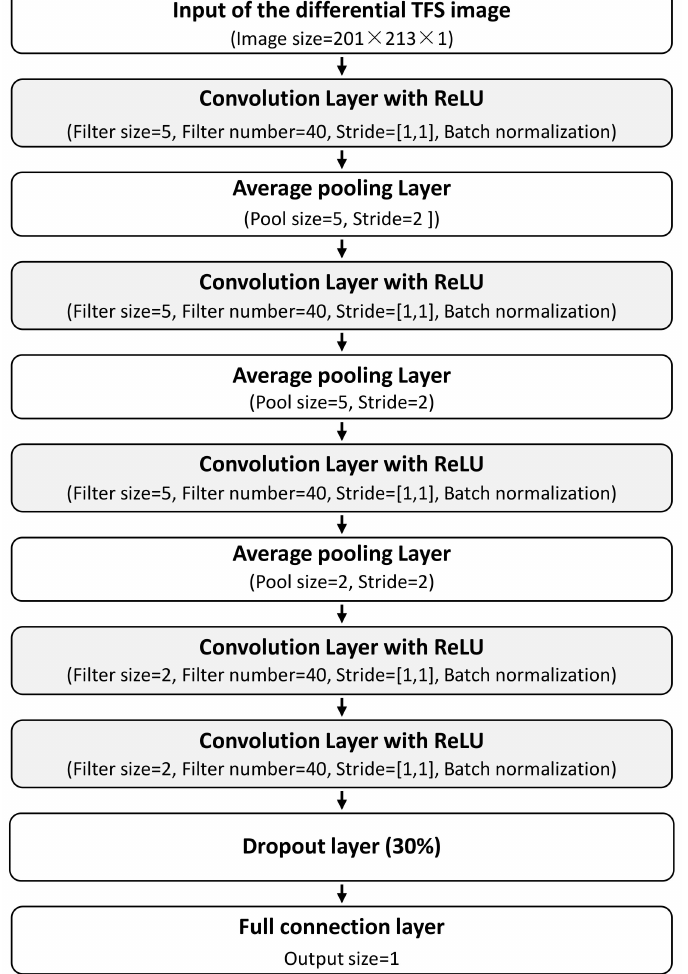
Figure 12. Structure of the CNN for fatigue crack